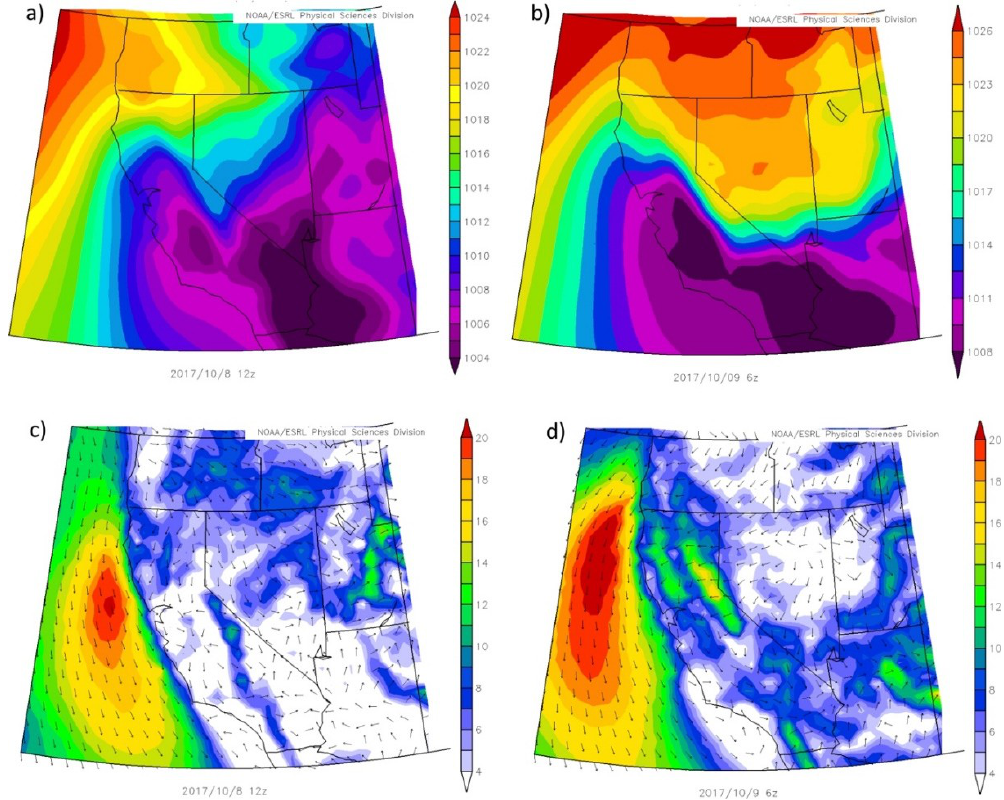
Figure 2. Hourly mean for the National Centers for Environmental Prediction (NCEP) North American Regional Reanalysis composites interpolated to 0.3 × 0.3 degrees for ( a ) surface pressure at 8 October, 12 UTC; ( b ) surface pressure at 9 October, 9 UTC; ( c ) 1000 mb vector wind at 9 October, 12 UTC; and ( d ) 1000 mb vector wind at 9 October, 9 UTC. Image provided by the National Oceanic and Atmospheric Administration (NOAA) Earth System Research Laboratory, Physical Science Division from their website at http://www.esrl.noaa.gov/psd/.